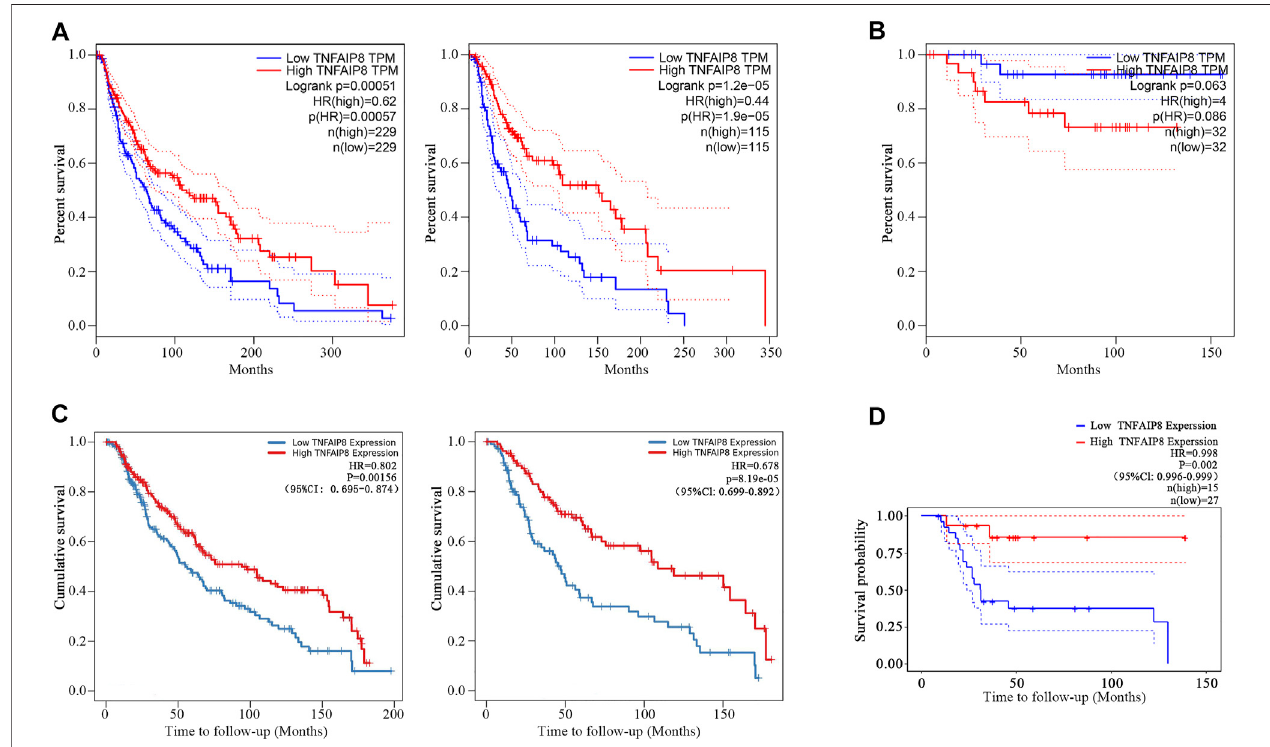
FIGURE 3 | Prognostic value of TNFAIP8. (A) The overall survival analyses of TNFAIP8 in SKCM via GEPIA. Left: median cutoff group; right: quartile cutoff group. (B) TheoverallsurvivalanalysesofTNFAIP8inKICH via GEPIA. (C) TheimpactofTNFAIP8mRNAexpressiondifferenceonoverallsurvivalinbothSKCM(left)andSKCM metastasispatients (right) via theTIMER onlineplatform. (D) Comparing thehigh andlowexpression levelsofTNFAIP8 inskin melanoma patientswithKaplan – MeierOS curves by PrognoScan (GSE19234).